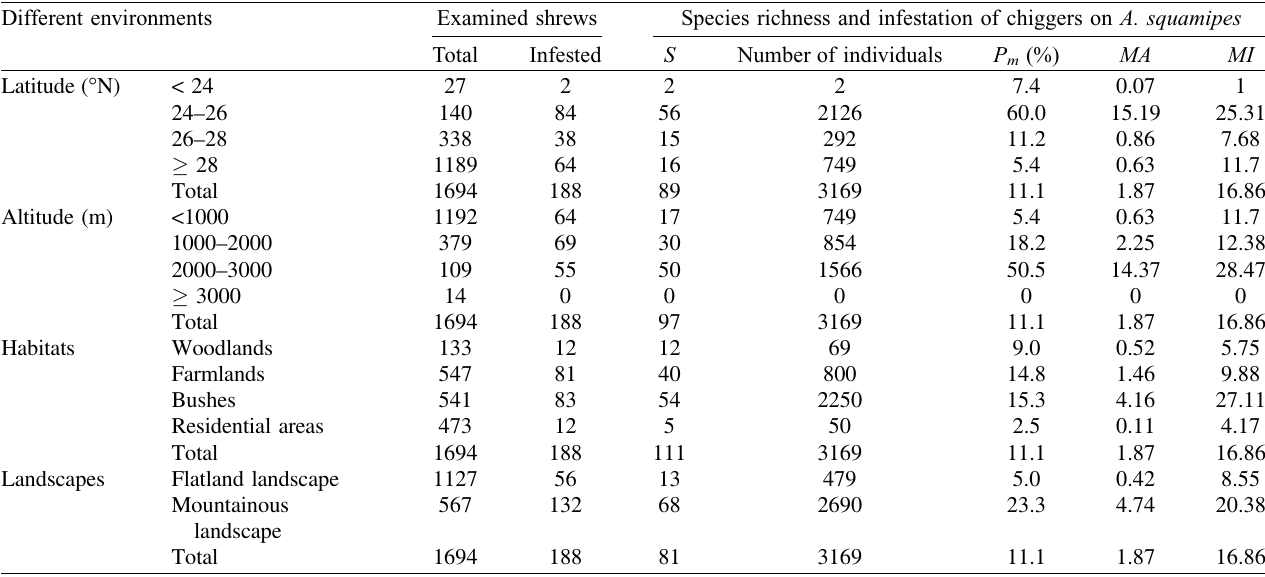
Table 4. Infestations of Anourosorex squamipes shrews with chiggers in different environments in Southwest China (2001 – 2019). Different environments